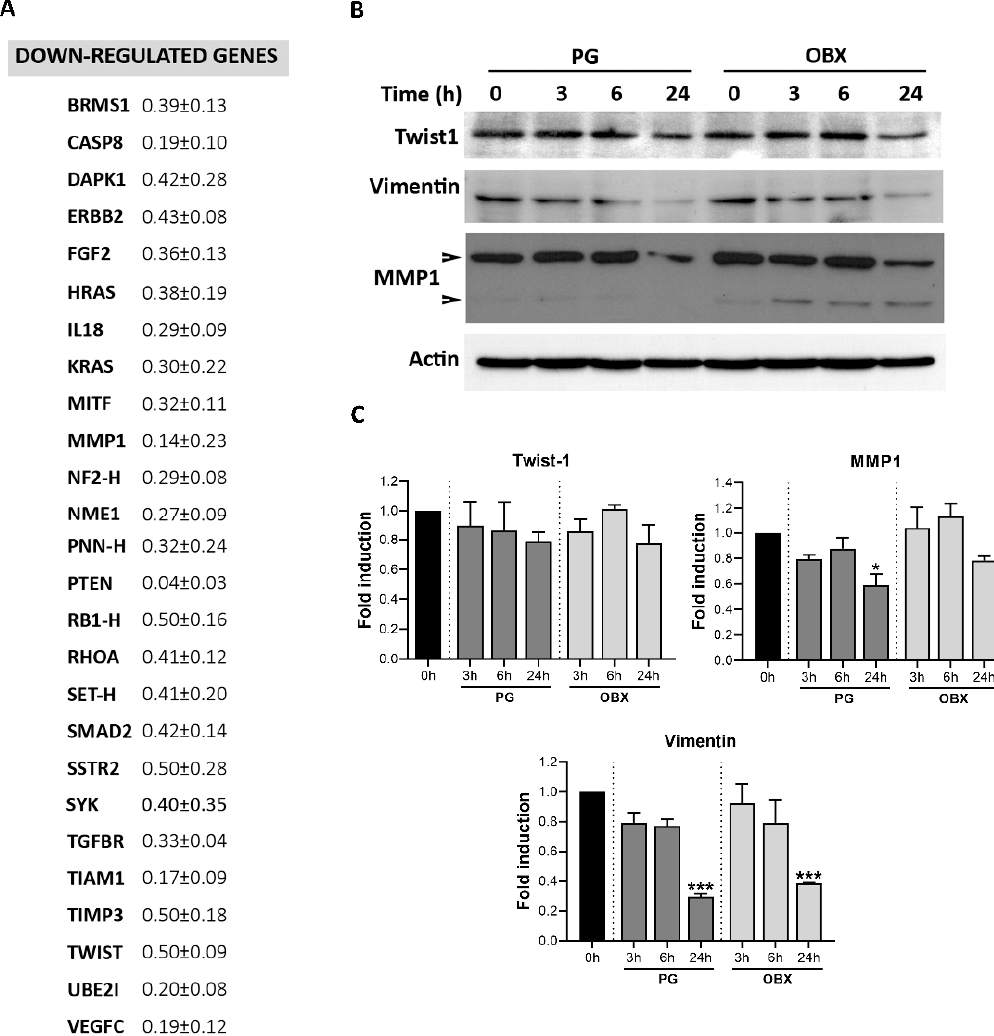
Figure 4. Metastasis-related gene and protein-expression modifications after PG and OBX treatments. ( A ) Gene-expression profiling of SK-MEL-5 melanoma cells after PG treatment (0.5 µM 16 h) was assessed through TLDA technology. ( B , C ) Protein-expression levels of metastasis-related proteins twist-1, vimentin and MMP-1 in PG- and OBX (500 nM)-treated SK-MEL-5 cells were assessed through Western blot from 3 to 24 h. Actin expression was used as loading control. Representative images of three independent experiments are shown. Figure shows mean ± SEM. Statistical differences from control 0 h are shown as *** p < 0.001 and * p <